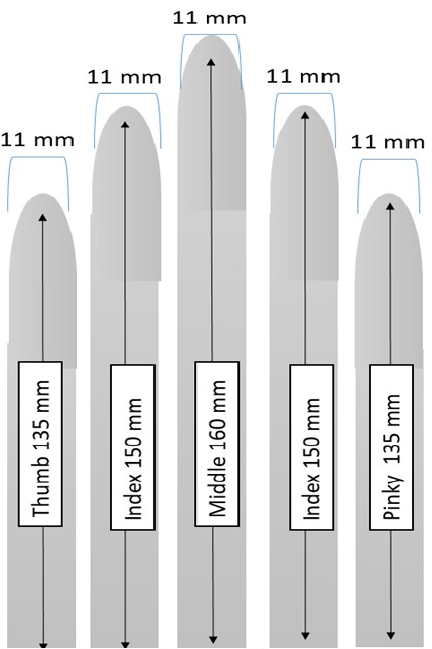
Figure 2. Dimensions of height and width of the actuators for each finger.